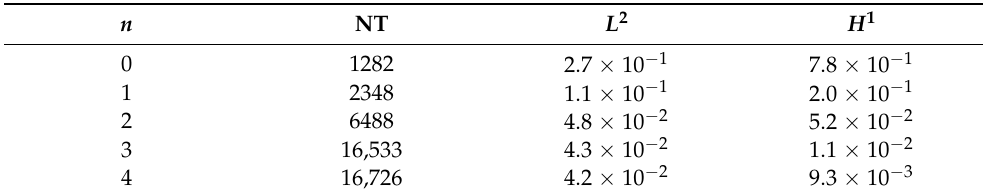
Figure 12. Adapted meshes. ( Left ) The mesh obtained at the last level by using the η N error estimator. ( Right ) The final stage of the adapted mesh by using the gradient-based error estimator. Table 6. Error in L 2 norm and H 1 seminorm for example 2 obtained with the “Neumann auxiliary” error estimator.